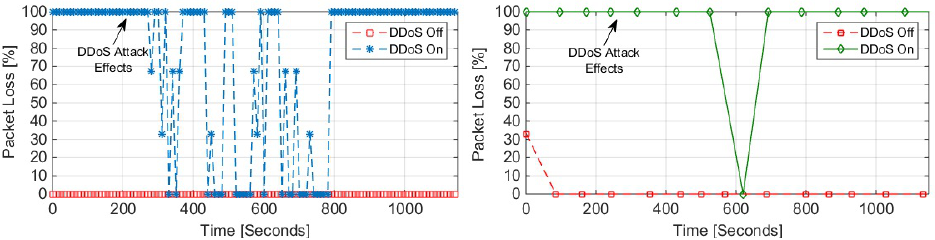
Figure 6. SDN-based IoT network performance under normal operation conditions.